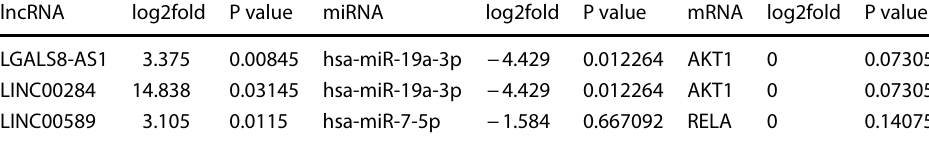
lncRNA log2fold P value